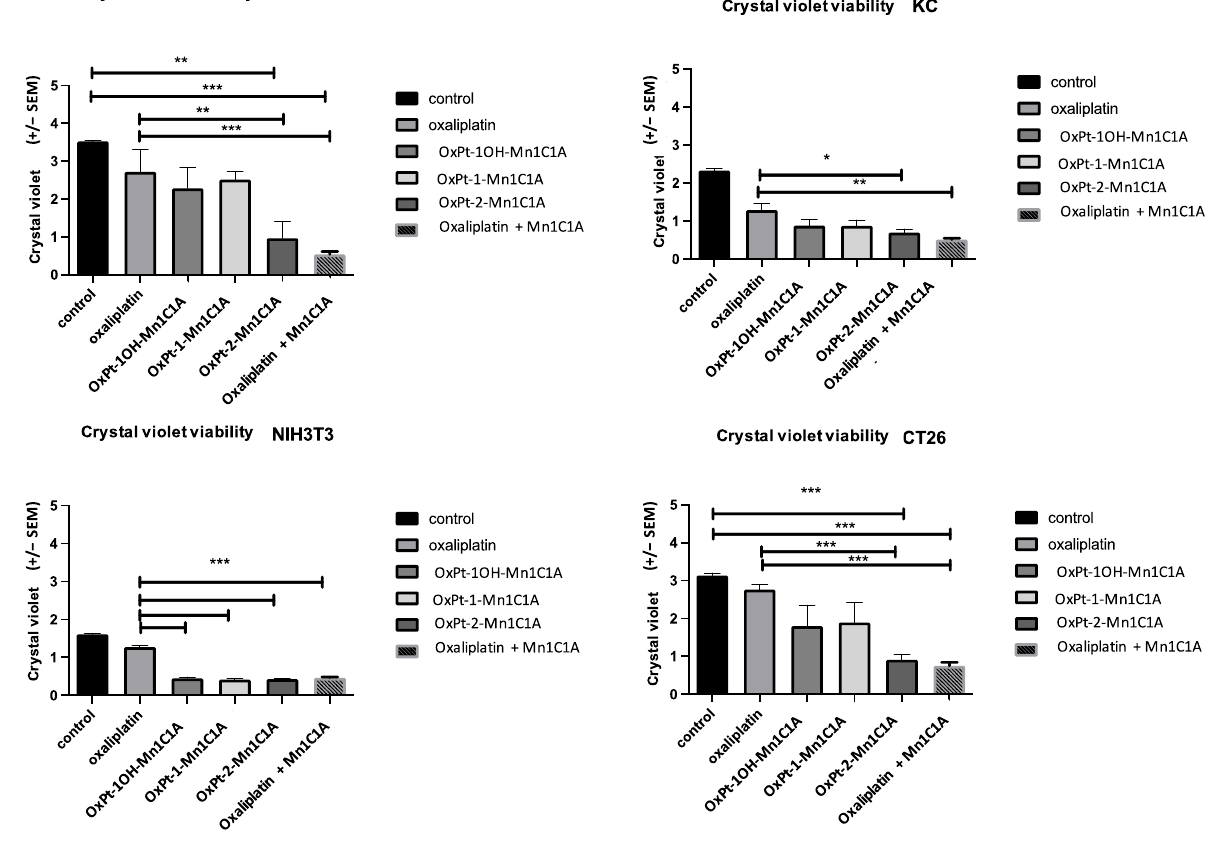
Figure 3. Crystal violet cell viability assessed on day 2 after 24 h of treatment exposure. Mean absorbance (at 570 nm) in cell lines treated with vehicle, oxaliplatin, OxPt-1OH-Mn1C1A, OxPt-1-Mn1C1A, OxPt-2- Mn1C1A, and Mn1C1A + oxaliplatin at 2.5 μM, 5 μM , and 10 μM. The p -values are denoted as follows: * p < 0.05, ** p < 0.01, *** p < 0.001. In all cell lines, cytotoxic activity was higher than oxaliplatin in cells treated with OxPt-2-Mn1C1A and Mn1C1A + oxaliplatin ( p < 0.05). Cell viability assessed by crystal violet was also measured on a primary culture of murine fibroblasts (Figure 4). The Pt(IV) conjugates and oxaliplatin + Mn1C1A had signif- icantly higher cytotoxicity on primary fibroblast culture cells than oxaliplatin alone. The MnSODm Mn1C1A alone was not cytotoxic on fibroblasts.